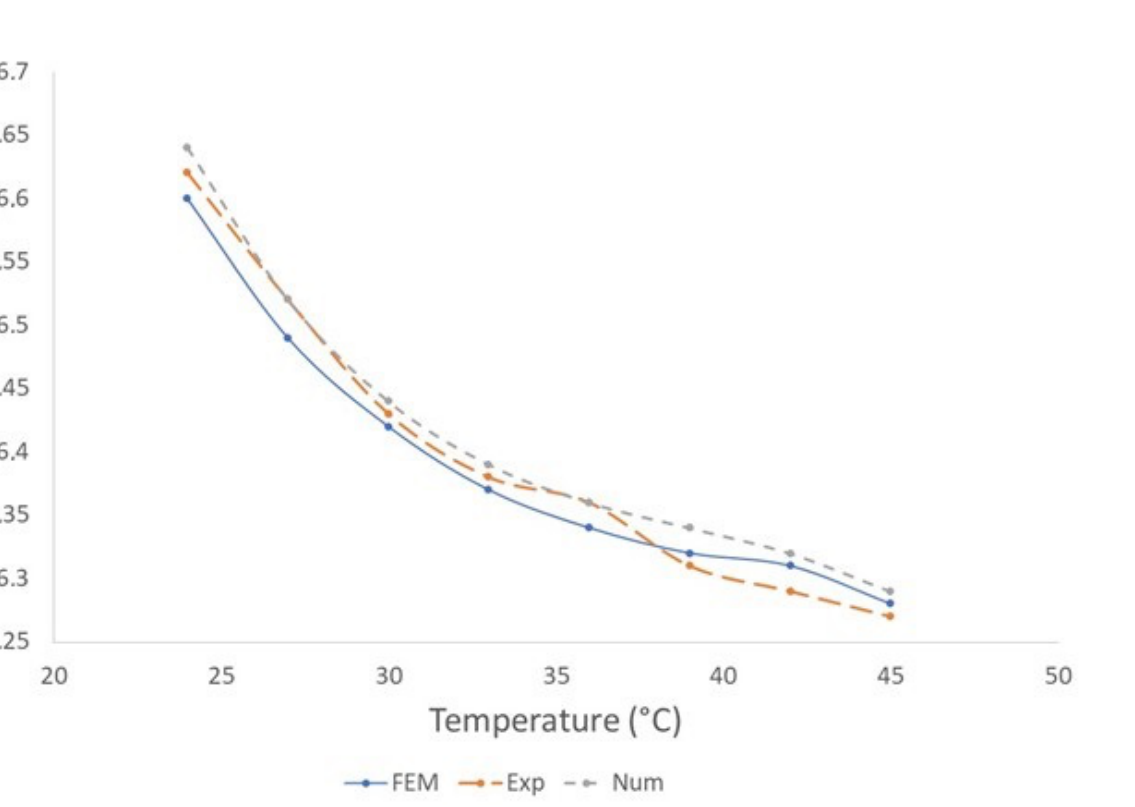
Figure 6. Decreased braking torque when there is an increase in temperature to the ECB using a plain conductor